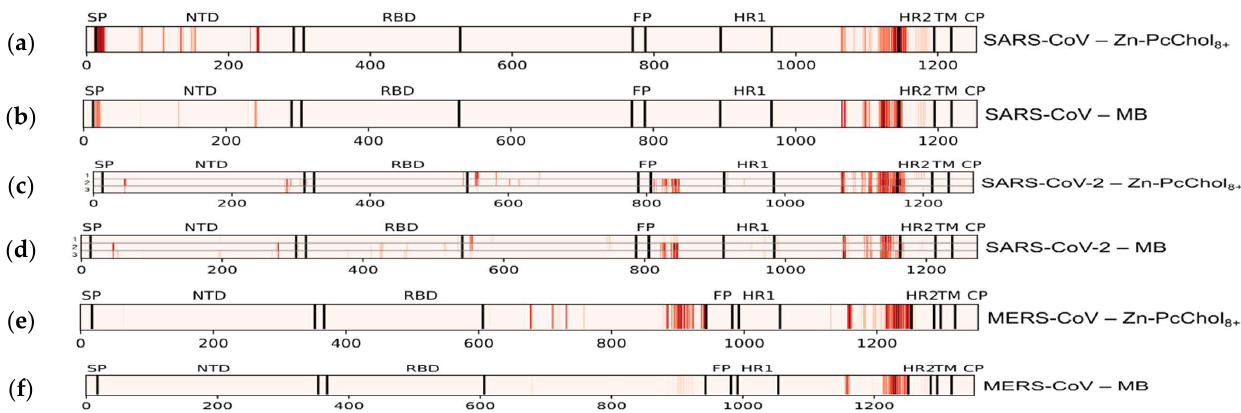
Figure 4. Amino acid residues in primary sequences of SARS-CoV ( a , b ), SARS-CoV-2 ( c , d ), and MERS-CoV ( e , f ) with assignment of functional domains colored depending on the probability of PS binding. (c1,d1) are related to the SARS-CoV-2 S-protein protomers in the “open” state, and (c2,c3,d2,d3)—to the S-protein protomers in the “closed” state.